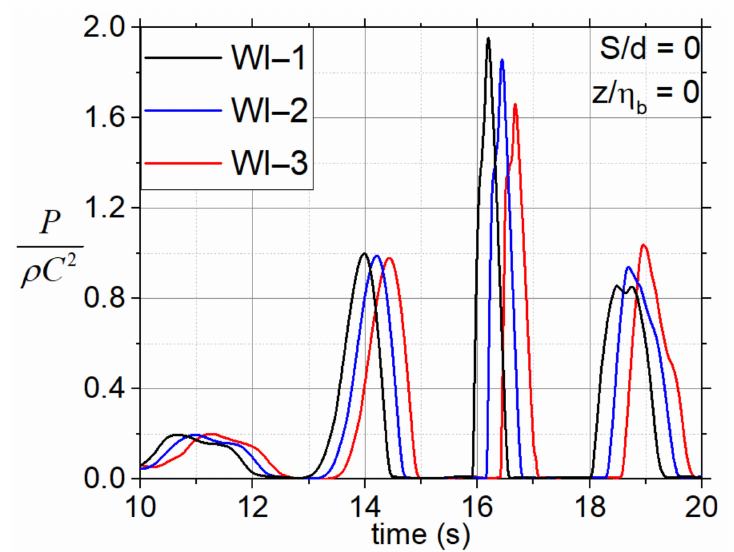
Figure 17. The normalised pressure time history for the three-wave impact scenarios, WI-1, WI-2 and WI-3 at normalised airgap, S/d = 0 and z/ η b =